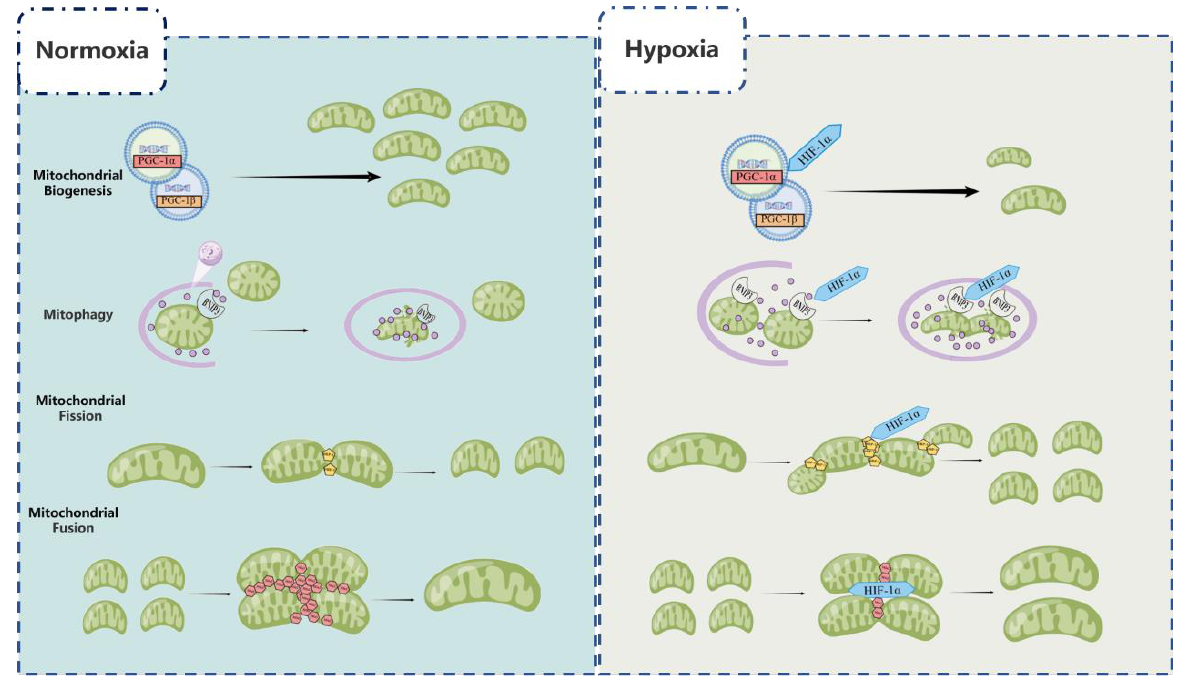
Figure 1. Regulation of mitochondrial number by HIF-1.